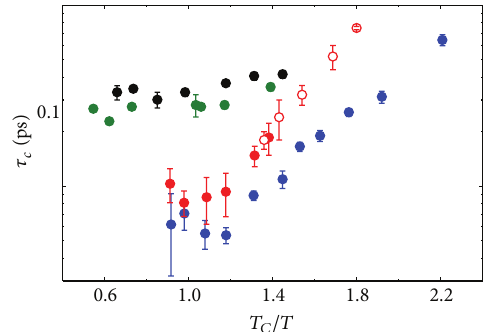
Figure 18: The 𝑄 = 0 extrapolated relaxation timescale measured by IXS in [40] for several prototypical fluids as on neon (black dots), nitrogen(olivedots),ammonia(reddots),andwater(bluedots).The relaxation times of ammonia extracted from the IXS work in [41] are also reported for comparison as open dots.